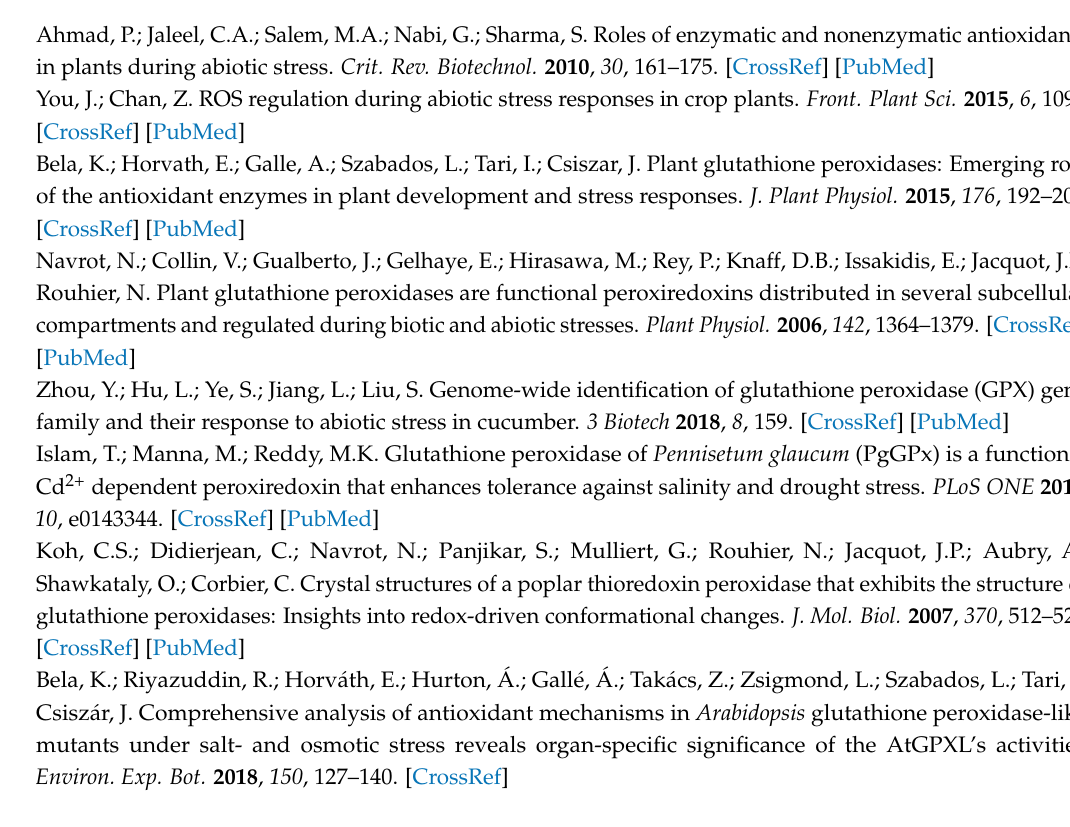
Table S1: Primers used for qRT-PCR, Table S2: GPX protein sequences used for phylogenetic tree analysis, Table S3: The predicted promoter cis -acting regulatory elements of ClGPX